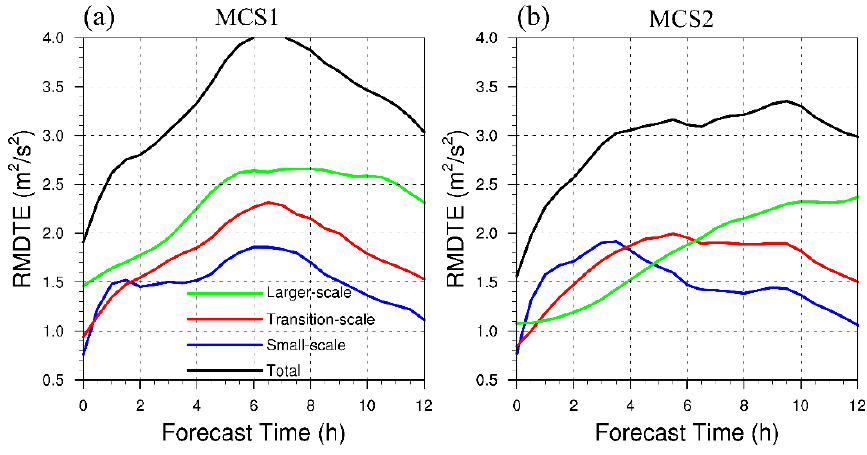
Figure 6. Time evolution of RMDTE at different spatial scales (Total: black curves; Small-scale: blue curves; Transition-scale: red curves; Larger-scale: green curves) in the ( a ) MCS1 region and ( b ) MCS2 region.